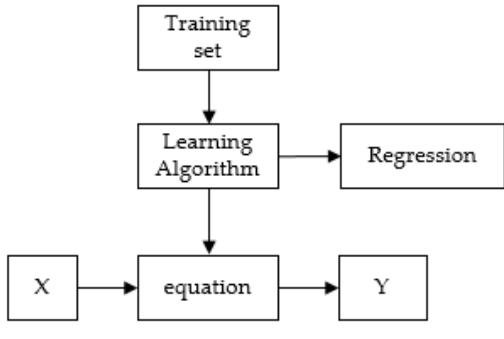
Figure 13. Process flow of model fitting.